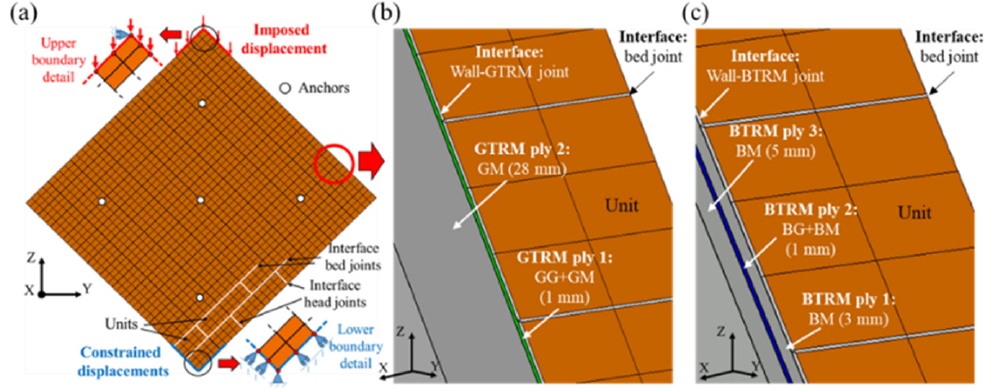
Figure 12. ( a ) Numerical model layout; representation of the ( b ) GTRM–wall and ( c ) BTRM–wall Figure 12. ( a )Numericalmodellayout; representationofthe( b )GTRM–walland( c interactions.